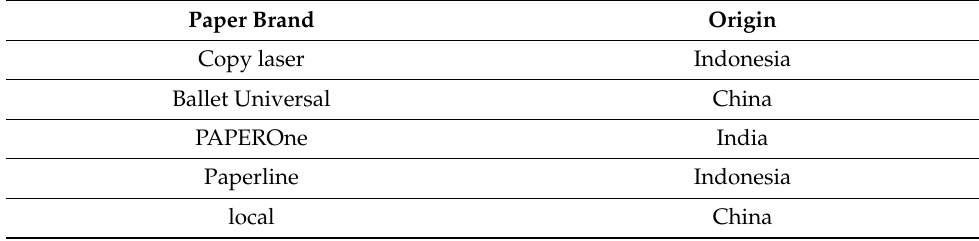
Table 2. Paper types used in the preparation of test samples.